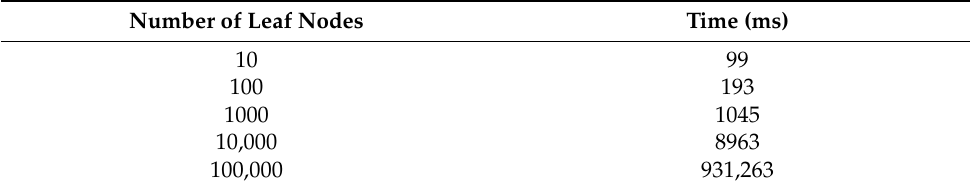
Table 9. The Performance of Constructing Merkle Tree.